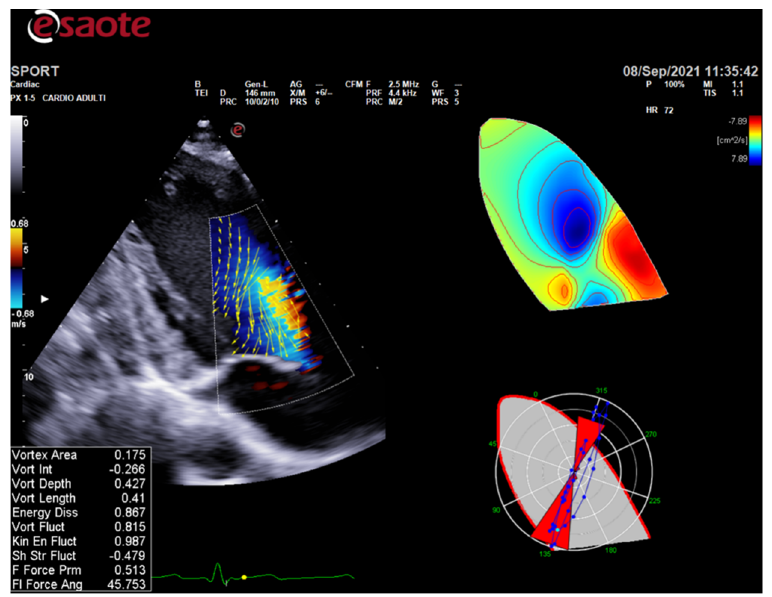
Figure 3. HyperDoppler flow analysis in an endurance athlete. On the left, the flow velocity vector map shows the blood flow that circulates towards the direction of the left ventricular outflow tract. On the right, the circulation parametric map brings to light the formation of a pair of vortices immediately below the aortic valve.